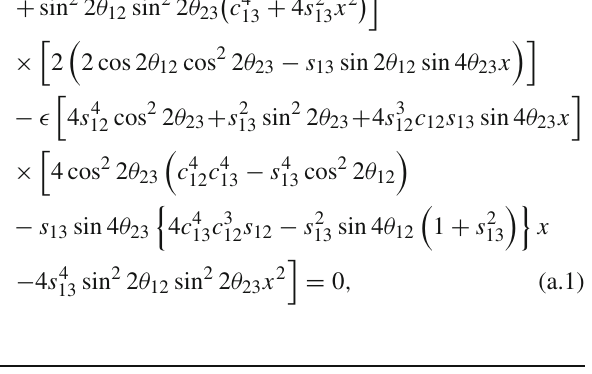
Table 7 The list of the functions R 2 , 3